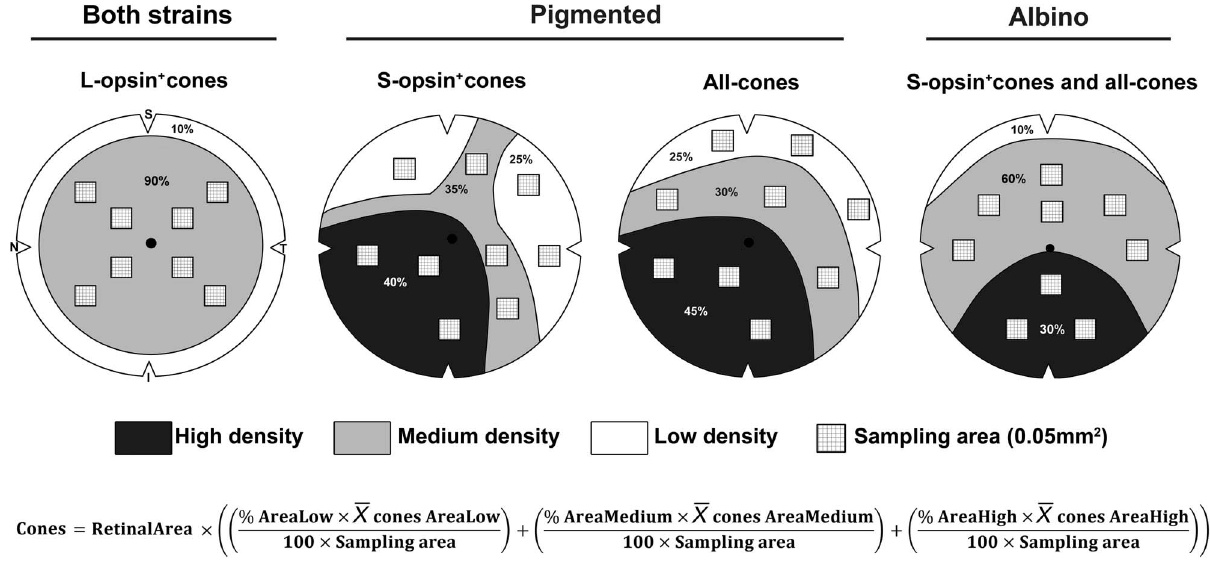
Figure 6. How to sample the mouse retina to accurately infer each cone population. Schematic drawings of a right retina showing the minimum number of sampling areas of 0.05 mm 2 needed to manually quantify and infer the total cone population in both strains. In each drawing are shown the cone density regions wherefrom the samples should be taken. The inference of the total cone population can be calculated following the mathematical formula at the bottom of the figure, where the retinal area should be previously measured in mm 2 , % of area low is 25, % of area medium is 30–90, % of area high is 30–45 (depending on the cone population, see drawings), sampling area is 0.05 mm 2 and (cid:2) XX is the mean number of cones per density area (i.e. average of cones in the samples taken within each density region). S: superior, N: nasal, I: inferior, T: temporal.